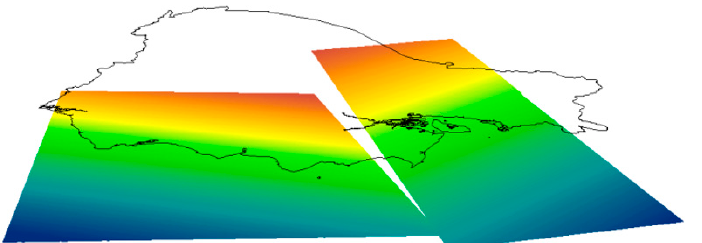
Figure 10. Models of the subduction planes of the Equator. The Benioff plane in the coastal region has a structural immersion of ~5°, between 40 and 70 km deep. A sudden change in dip is delineated in the Andean region, reaching its maximum inclination below the Amazon retro-arc basin, with the plane of inclination between 17° and 28° Taken from [10].